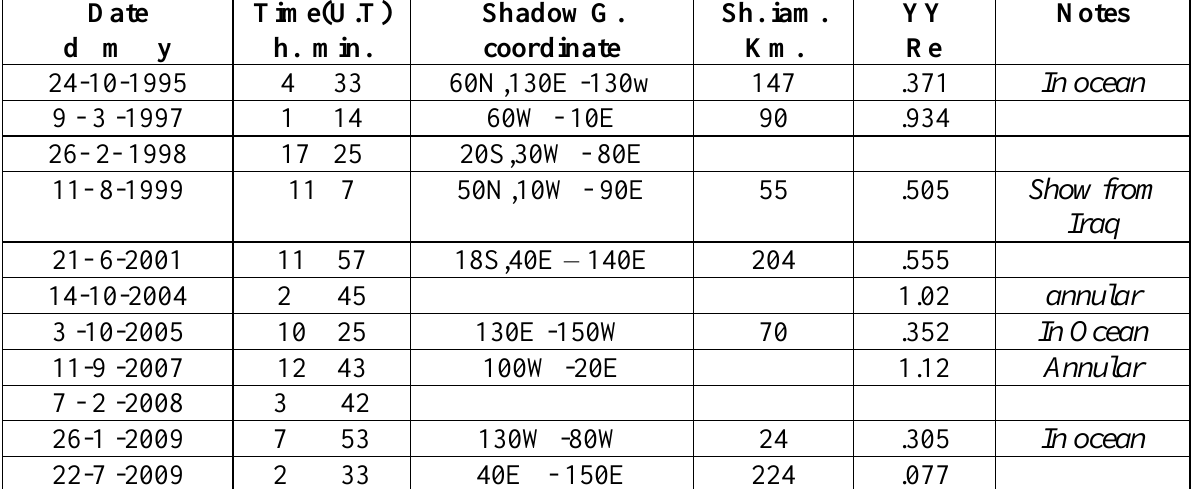
Table 12: total solar eclipse information